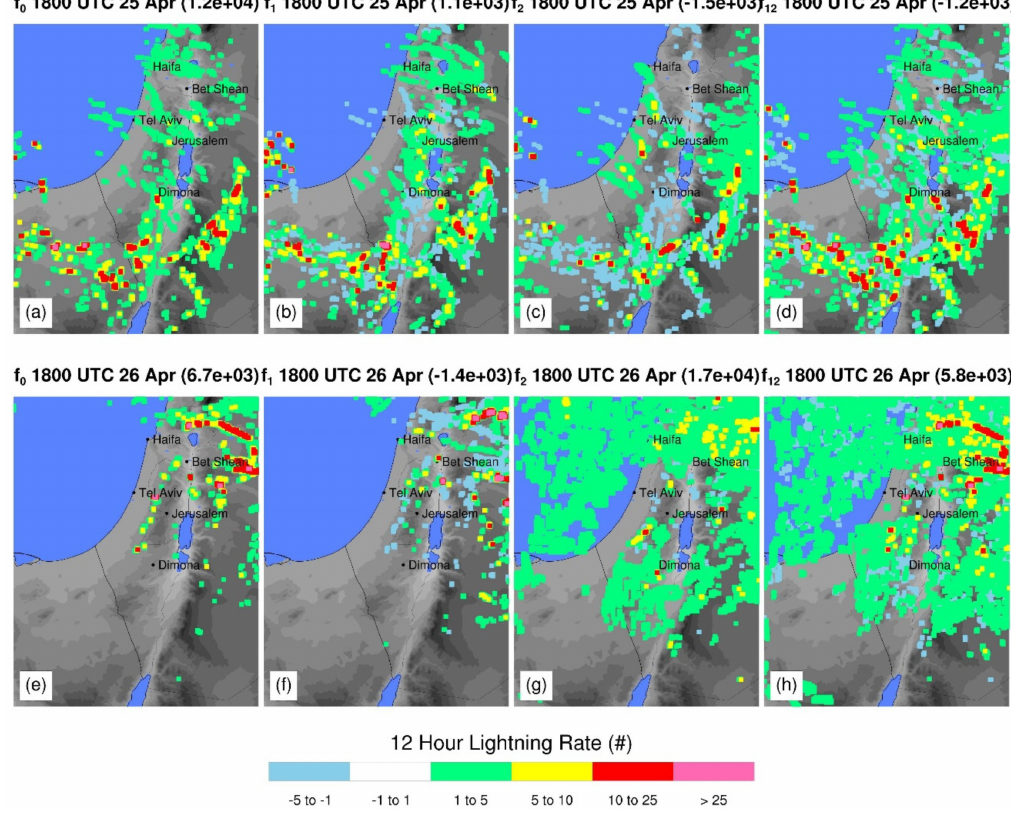
Figure 13. Factor separation maps for 12 h lightning rates from the 1.3 km (D03) domain. The factor f o ( a , e )is from the control simulation, while f 1 ( b , f ) represents the effect of local soil moisture on 12 h lightning rates. The factor f 2 ( c , g ) represents the effect of non-local moisture sources on lightning rates, while f 12 ( d , h ) shows the effect of coupled interactions of non-local and local moisture sources on 12 h lightning